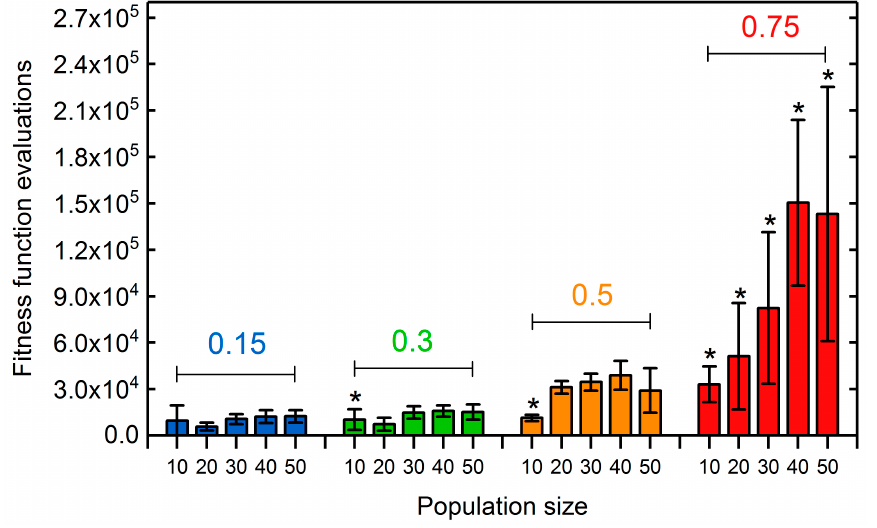
Figure 5. Number of fitness function evaluations until maximal final fitness was reached for GA runs applying population sizes between 10 and 50. Bars are clustered according to the employed selection rate (colored number). Error bars show the standard deviation among five replicates for each population size—selection rate pair. Asterisks denote parameter pairs with which the globally maximal fitness of 0.48 mol mol − 1 h − 1 was not reached in every replicate GA run after 900 generations. Succinate BPCY was used as the engineering objective. The intervention set size was